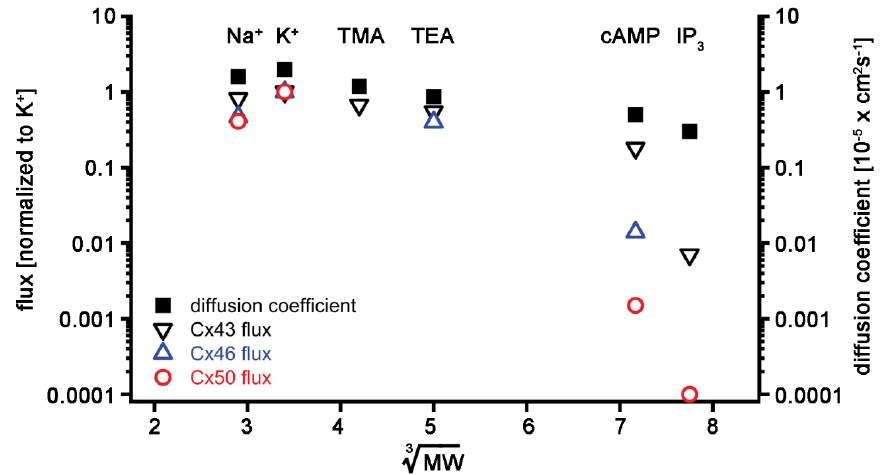
Figure 2. Summary of lens connexin permeability to ions (K, Na, TMA, and TEA) and second messengers (cAMP and IP 3 ): flux data of di ff erent solutes were normalized to their K + flux and plotted versus the cube root of their molecular weights for Cx43 (black open downward triangles), Cx46 (blue open upward triangles), and Cx50 (red open circles). The di ff usion coe ffi cients in aqueous solution were also plotted for comparison (black squares). The data were plotted on a log scale to better depict lowered flux for larger solutes like cAMP and IP 3 . See the text for references on the derivation of